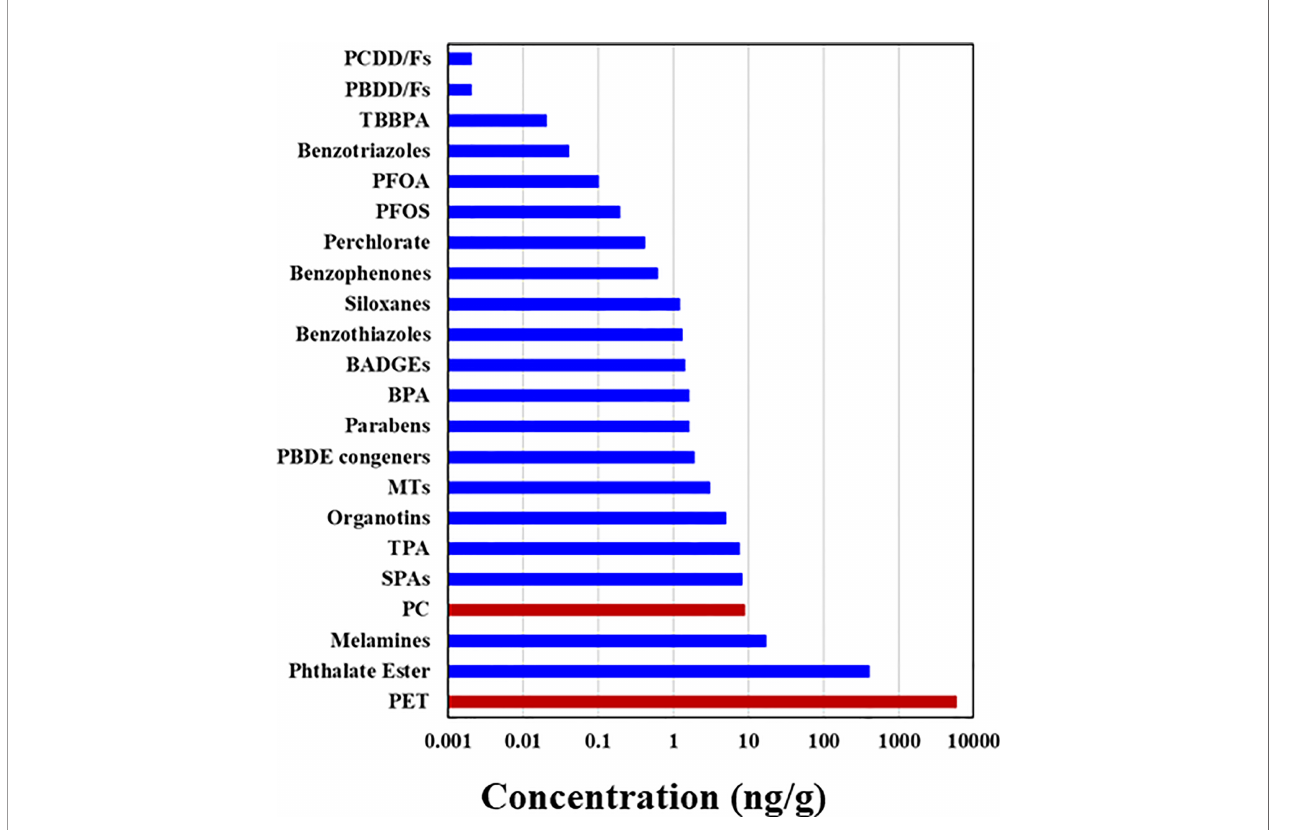
FIGURE 2 | Median concentrations of polyethylene terephthalate (PET) and polycarbonate (PC)-based microplastics measured in indoor dust samples collected from Albany, New York, USA, compared with those of other chemicals [see Zhang et al. (48) for details]; PCDD and PCDFs, polychlorinated dibenzo-p-dioxins and dibenzofurans, respectively; PBDD and PBDFs, polybrominated dibenzop-dioxins and dibenzofurans, respectively; TBBPA, tetrabromobisphenol A; PFOA, per fl uorooctanoic acid; PFOS, per fl uorooctanesulfonate; BADGEs, bisphenol A diglycidyl ether; PBDEs, polybrominated diphenyl ethers; MT, metabolites of 2,6-di- tert -butyl-4-hydroxytoluene; SPAs, synthetic phenolic antioxidants; TPA, terephthalic